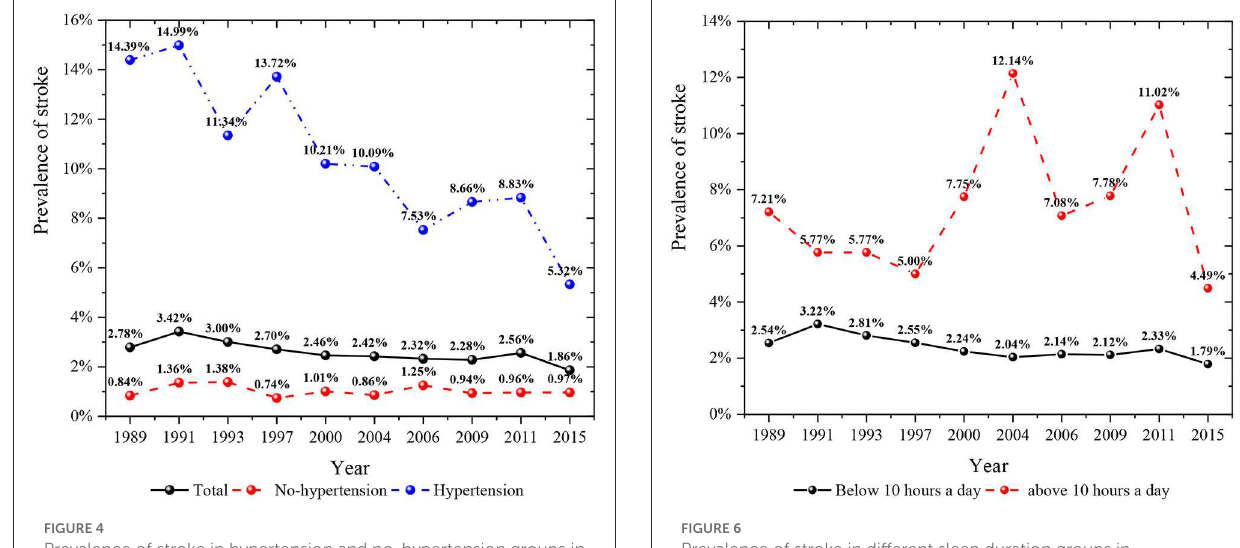
FIGURE4 Prevalence of stroke in hypertension and no-hypertension groups in 1989–2015.